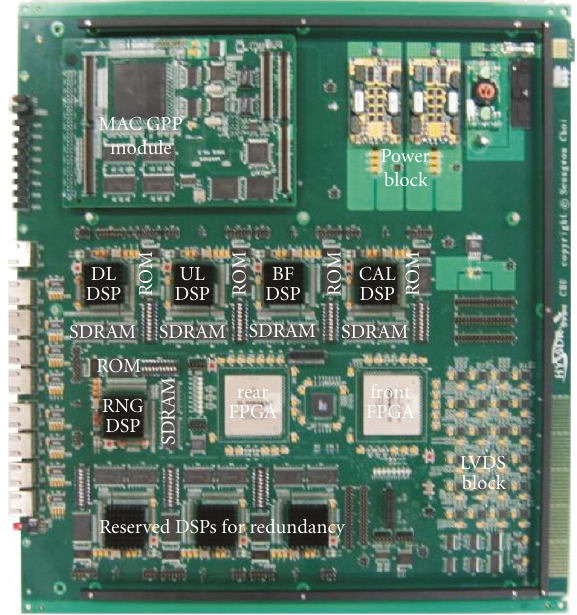
Figure 5: Photograph of the SA modem for the m-WiMAX SA